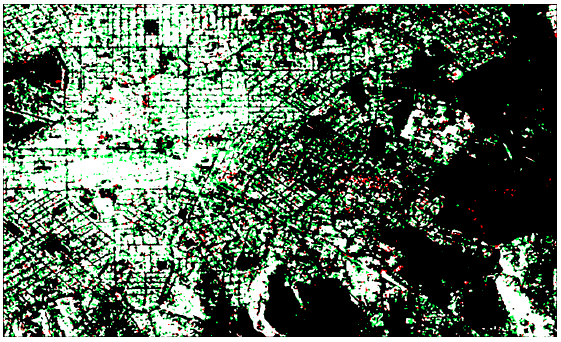
Figure 5. Comparison of the average amplitude data before and after the earthquake